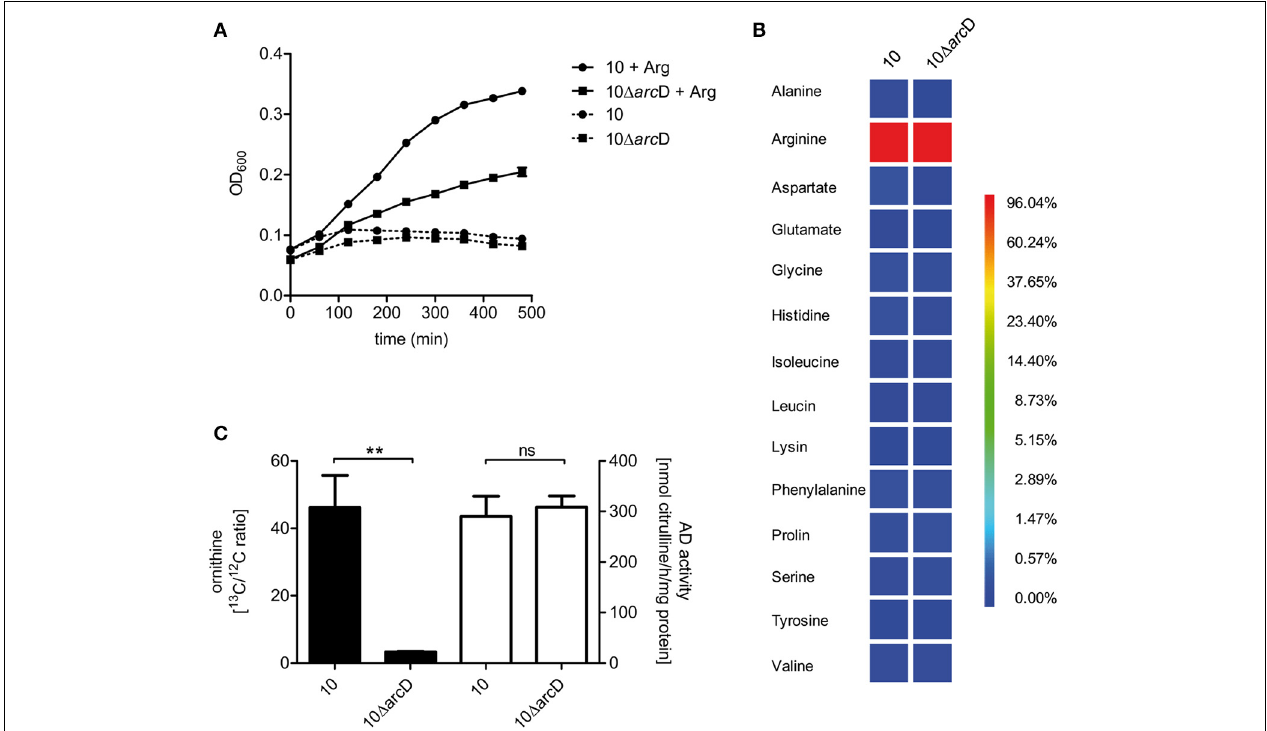
map. Results are shown for one representative experiment. (C) Measurement of 13 C incorporation in ornithine after [U- 13 C 6 ]arginine uptake of S. suis . After growth in CDM with 12 C-arginine, S. suis strain 10 and strain 10 (cid:2) arc D were incubated in CDM supplemented with 2.5mM [U- 13 C 6 ]arginine for 30min. The 13 C/ 12 C ratio of intracellular ornithine was determined as an indirect measure of arginine uptake (black bars, left y-axis). No difference in arginine deiminase (AD) enzymatic activity was observed for both strains under these conditions (white bars, right y-axis). Results are given as mean and standard deviation of three independent experiments. Statistical significance is indicated for a two-sided t -test ( ∗∗ p < 0 . 01; ns, not